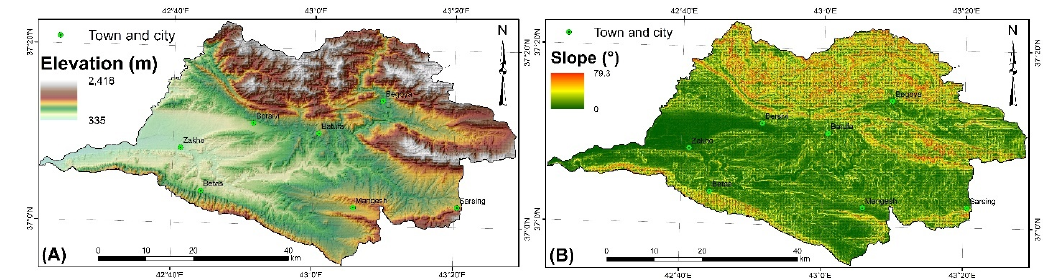
Figure 7. Maps of: ( A ) elevation, and ( B ) slope gradient of the study area.